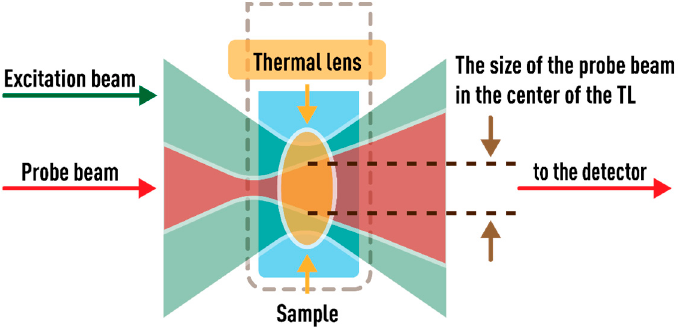
Figure 19. Scheme of beam propagation through the sample at a mode-mismatch factor less than